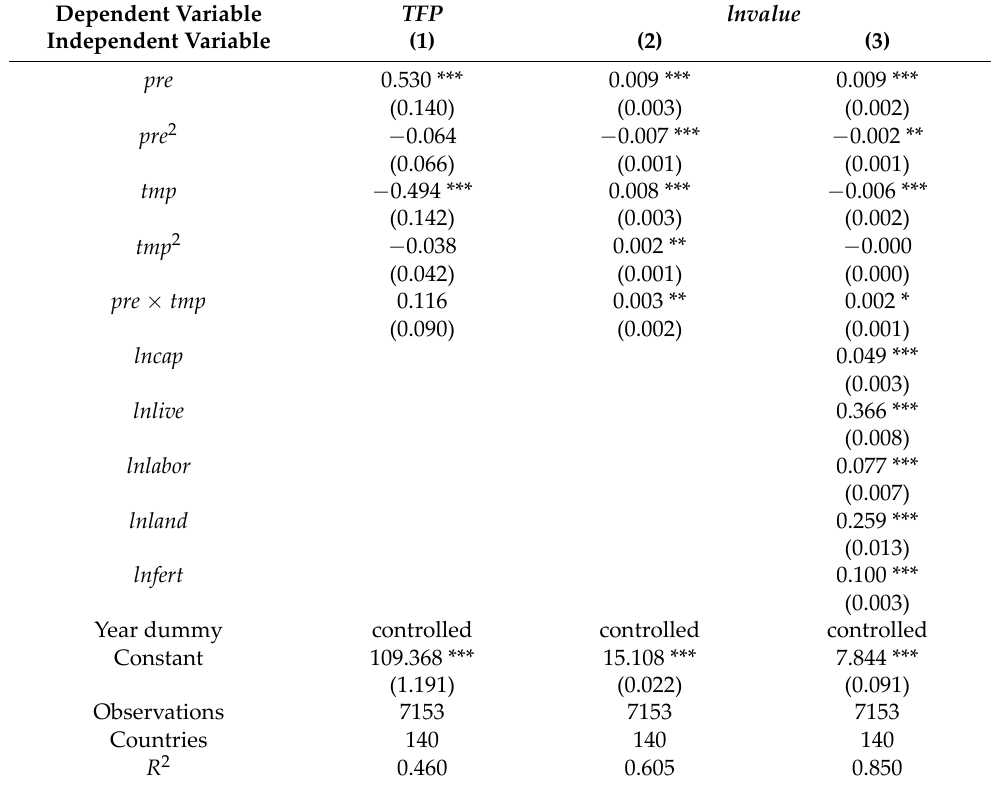
Table 4. Impact of climate change on